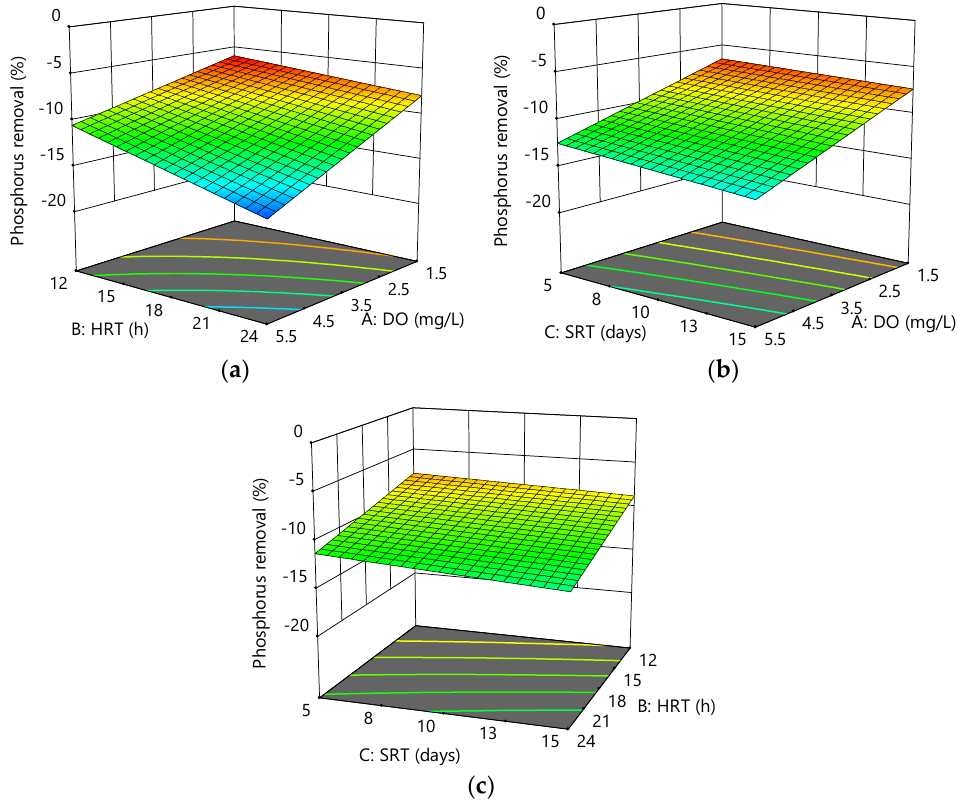
Figure 6. Response surface plots for phosphorus removal efficiency as a function of the following: ( a ) HRT and DO at SRT = 10 days; ( b ) SRT and DO at HRT = 18 h; ( c ) HRT and SRT at DO = 3.5 mg/L.